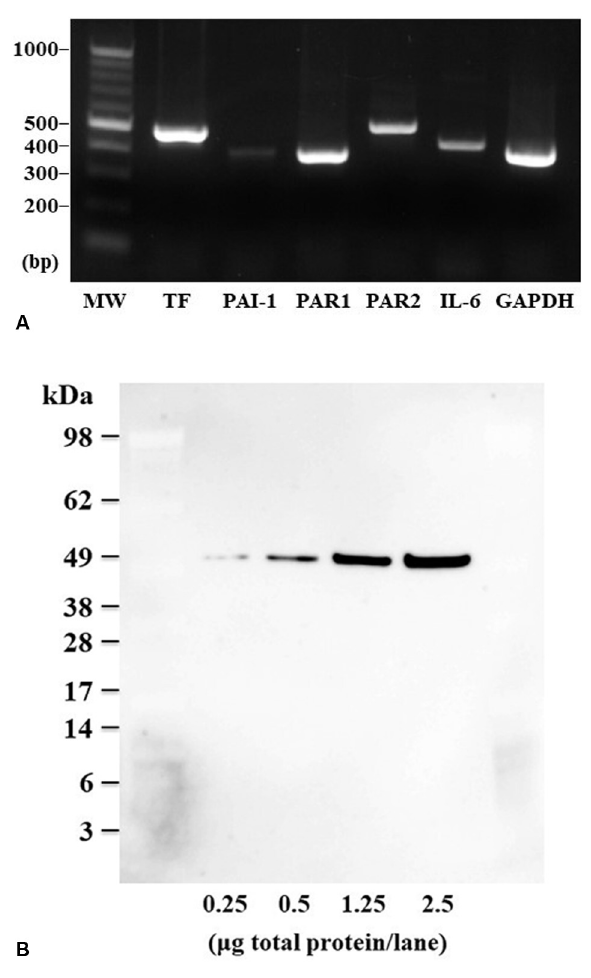
Fig. 1 ( A ) mRNA expression of coagulation and in fl ammation factor genes in cultured Colon26 cells determined using PCR. GAPDH, glyceraldehyde 3-phosphate dehydrogenase; IL-6, interleukin-6; MW, molecular weight markers; PAI-1, plasminogen activator inhibitor-1; PAR1, protease-activated receptor-1; PAR2, protease-activated re- ceptor-2;; TF, tissue factor. ( B ) Western blot image of TF protein in total protein 0.25 to 2.5 μ g/lane of a cell extract of cultured Colon26 cells. The data indicate that the molecular weight of TF is approxi- mately